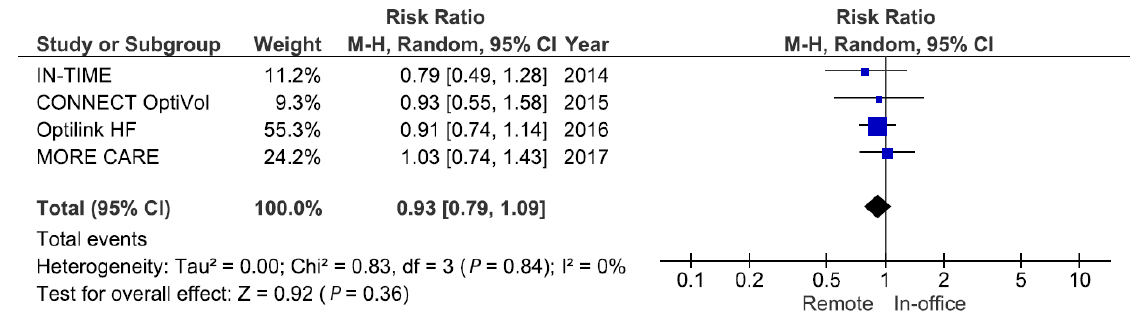
Figure 6. Pooled relative risk for randomized clinical trials examining the effect of remote monitoring on heart-failure- related hospitalization.